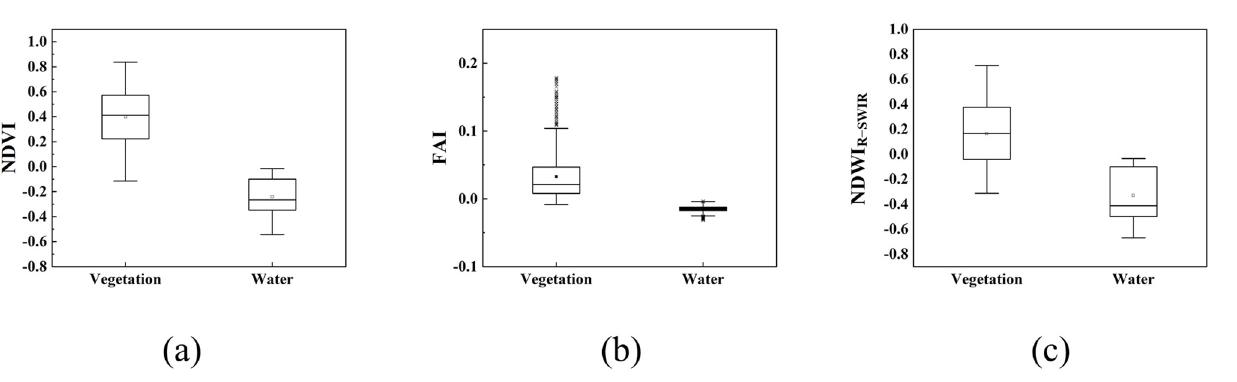
Figure 2. ( a ) NDVI, ( b ) FAI, and ( c ) NDWI R-SWIR values for water bodies compared to vegetation (algal blooms and aquatic vegetation).